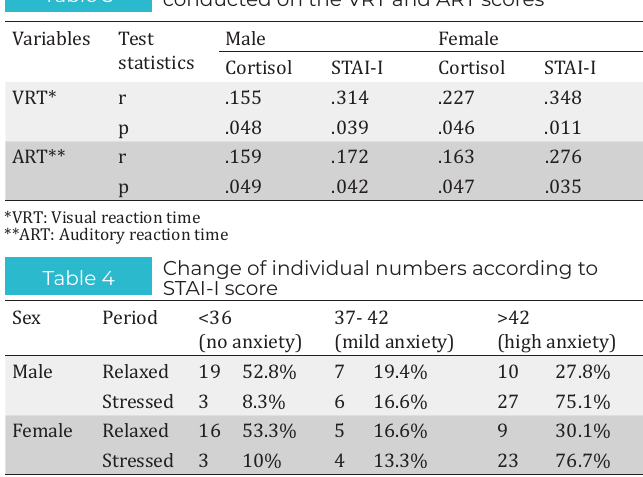
Spearman’s rho correlation analysis was performed to determine how VRT and ART values differed with Cortisol and STAI-I scores (Table 3). According to the results of the analysis conducted, a positive and weak correlation was found between VRT and ART and cortisol level and STAI-I scores in both Spearman rho correlation analysis results conducted on the VRT and ART scores